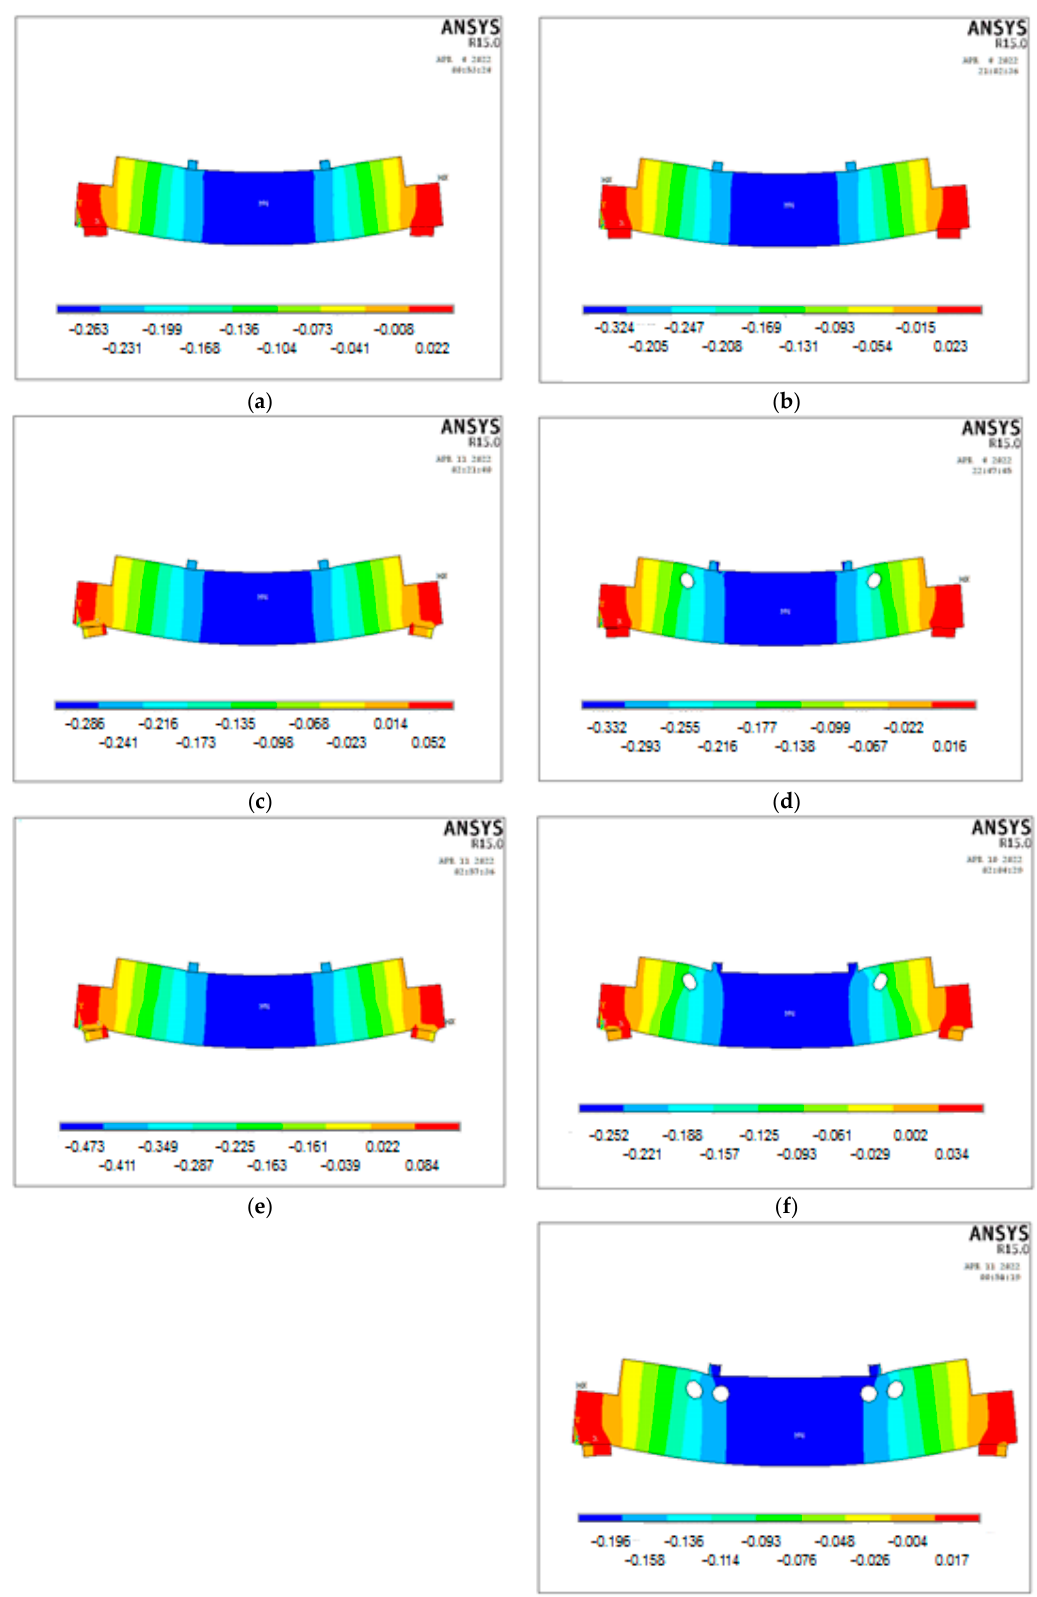
Figure 15. 3D de fl ection contours for all numerical models of RC girders with dapped ends. ( a ) Figure 15. 3D deflection contours for all numerical models of RC girders with dapped ends. DENT1. ( b ) DENT2. ( c ) DET3. ( d ) DET4. ( e ) DET5. ( f ) DET6. ( g ) DET7. ( a ) DENT1. ( b ) DENT2. ( c ) DET3. ( d ) DET4. ( e ) DET5. ( f ) DET6. ( g )